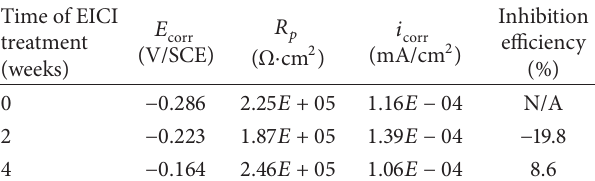
Table 3: 𝐸 corr , 𝑅 𝑝 , and 𝑖 corr values obtained from the weak polar- ization tests for uncontaminated samples with or without EICI treatment in sodium hydroxide solution.